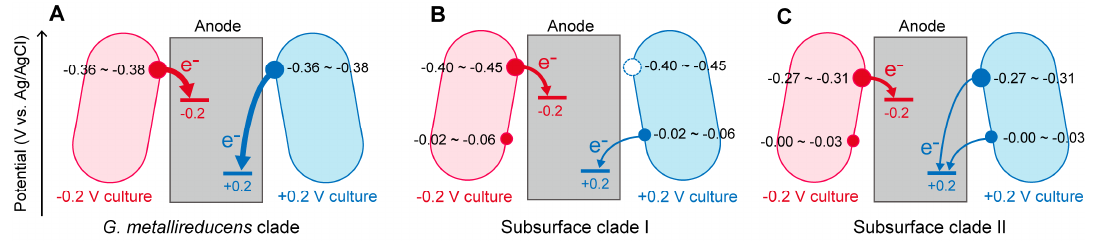
Figure 2. The schematic images of the switching of extracellular electron transfer (EET) paths responding to anode potentials. ( A ) The G. metallireducens clade species; ( B ) the subsurface clade I species; and ( C ) the subsurface clade II species. Red and blue circles represent EET paths (putatively different outer membrane c -type cytochromes (OMCs)). Filled and open circles represent EET paths expressed and not expressed, respectively.